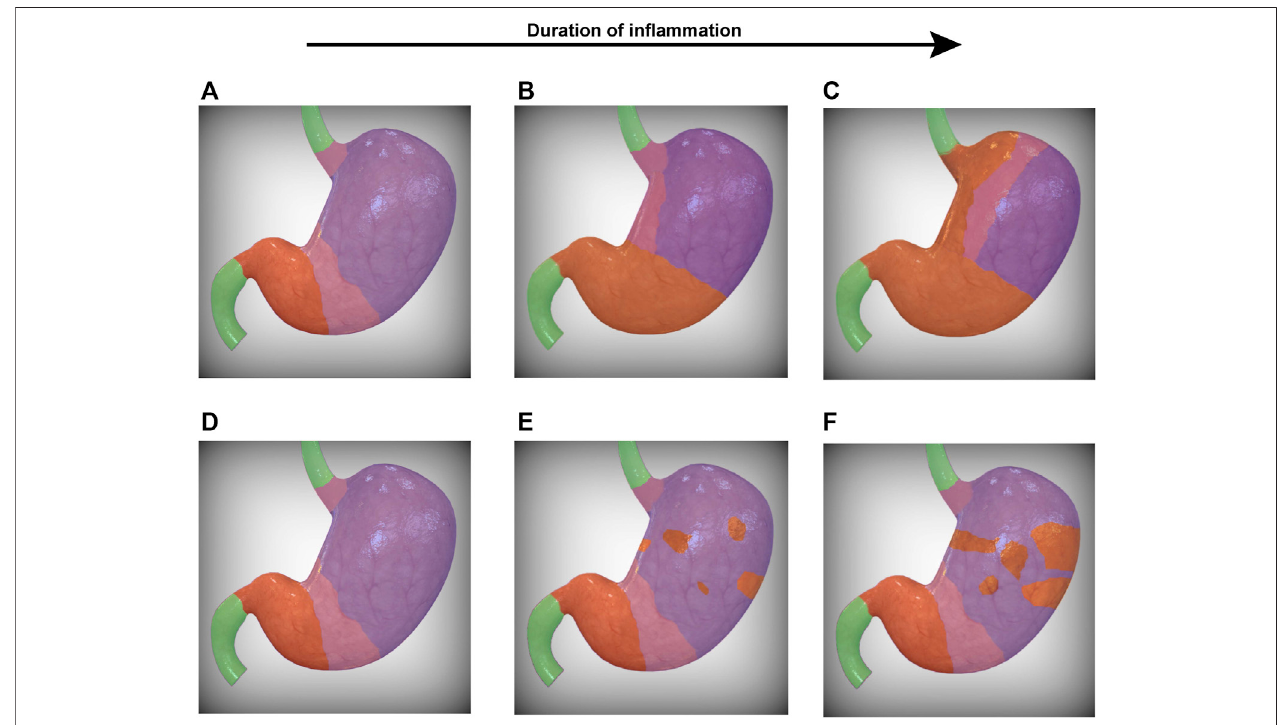
FIGURE 1 | Progression of SPEM within the stomach. Two possibilities for the topographic progression of SPEM are presented. In (A) , the corpus-antrum and gastroesophageal transition zones (pink) represent foci from which SPEM arises. In the setting of chronic in fl ammation, the transition zones converge along the lesser curvature (B) , leaving in their wake gastric glands that morphologically resemble antrum (orange). The transition zone therefore represents a dynamic demarcation that serves as the leading edge for the progressive front of SPEM that ultimately extends into the greater curvature of the stomach (C) . Alternatively, SPEM may arise frommultiplefociwithinthecorpus (E) ,graduallyspreadingradiallyandconvergingtoformalawnofSPEM (F) .Itshouldbenotedthatthesepossibilitiesarenotmutually exclusive and may occur simultaneously. SPEM, spasmolytic polypeptide-expressing metaplasia. The human stomach images were modi fi ed from a stock image purchased from